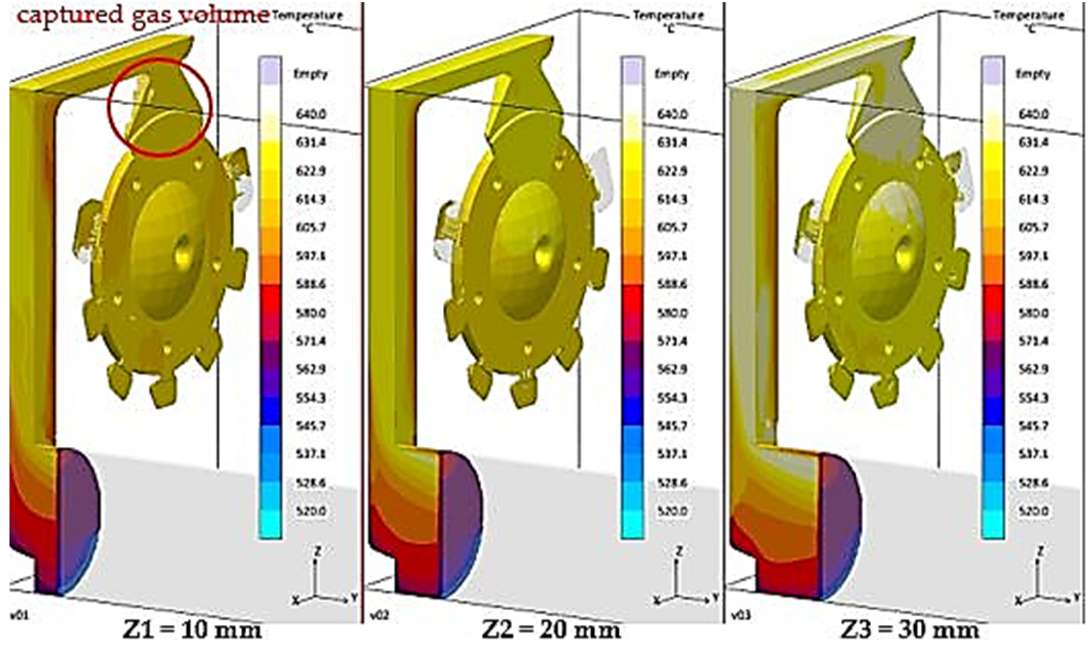
Figure 5. Gas entrapment in the case of 94% filling volume.